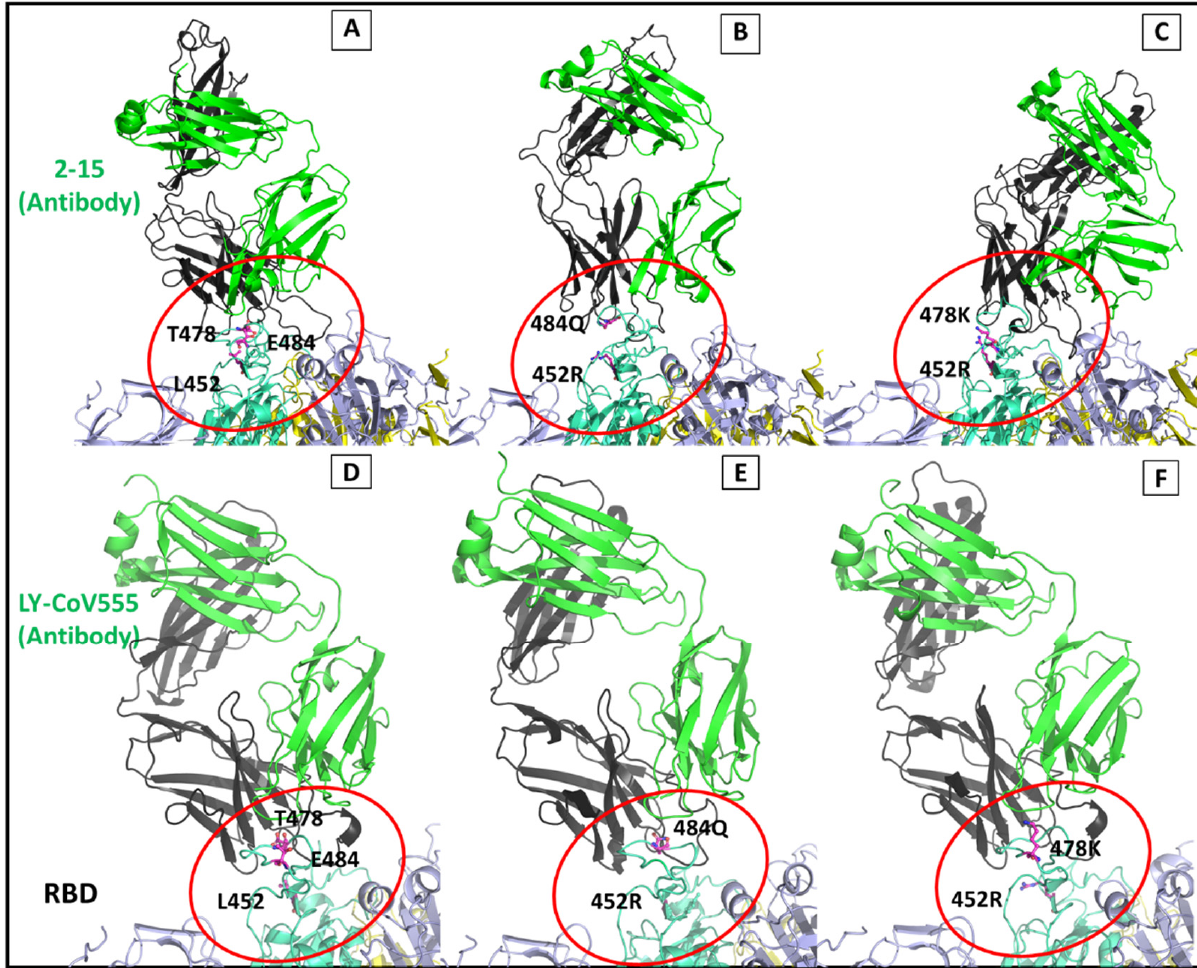
Figure 12. Diagrammatic representation of spike protein conjugated with antibody. ( A – C ) MD structure showing spike-2-15 antibody interface in wild, kappa and delta variants; ( D – F ) MD structure showing spike-LY-CoV555 antibody interface in wild, kappa and delta variant. The red circle highlights the interfacial site and the mutant residues.